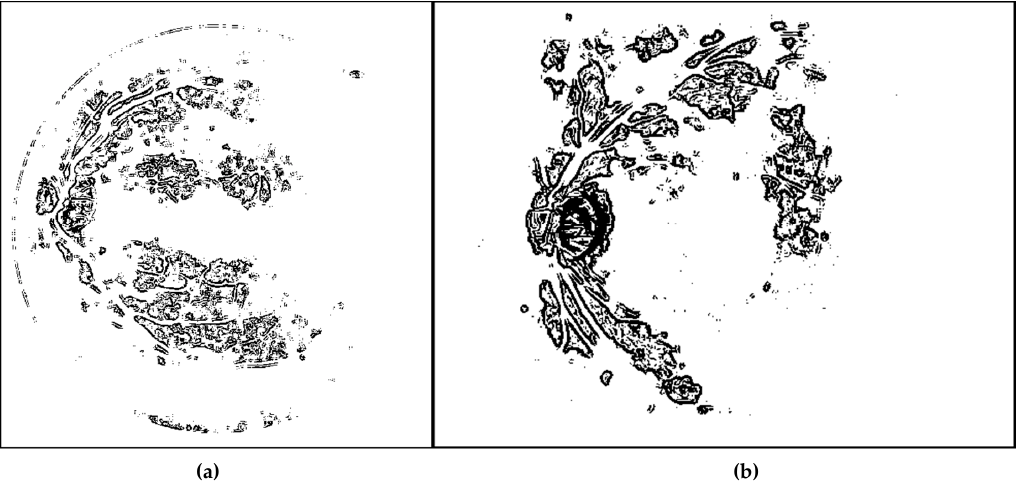
Figure 8. Implementing the modified robust rank order edge-detection algorithm. ( a ) is a healthy retinal image; ( b ) is a diseased retinal image.